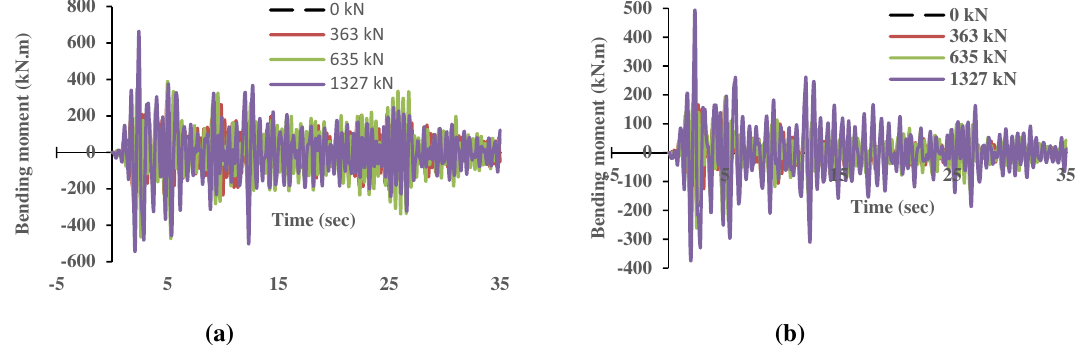
Fig. 16 Comparison of peak bending moment time-history of pile at ground level for different combinations of vertical loading in a NKD soil and b RCD soil when subjected to scaled IMV